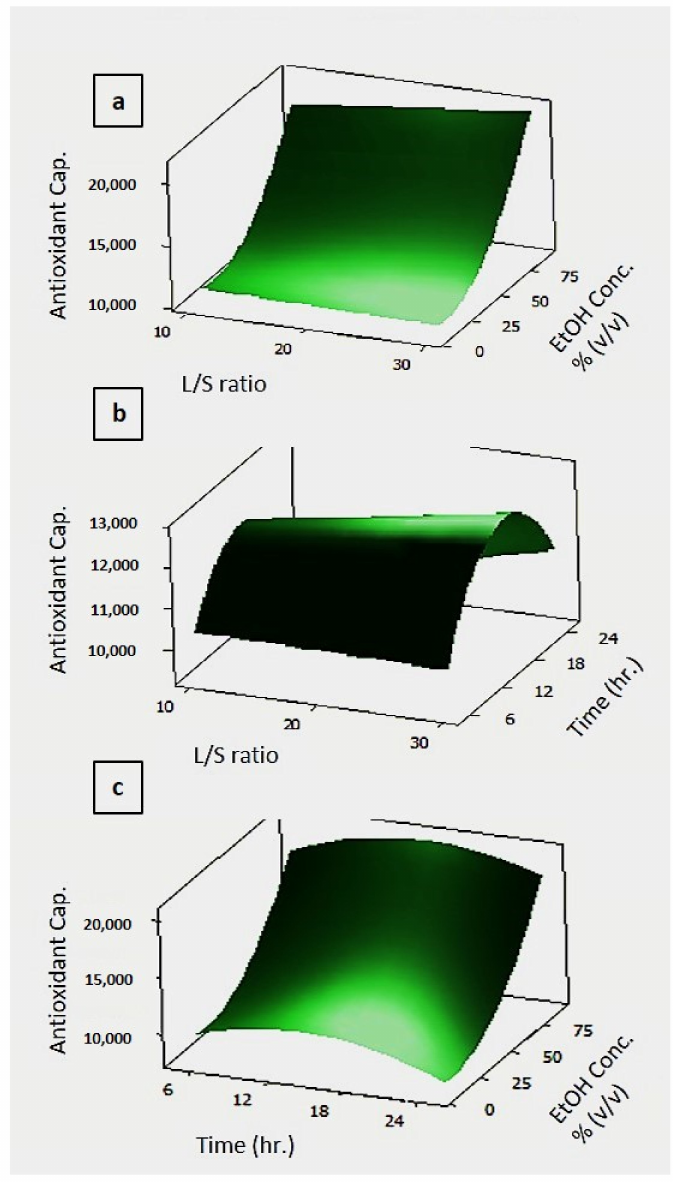
Figure 7. Effect of process parameters on the antioxidant capacity. In the figure, ( a ) antioxidant capacity vs EtOH concentration and L/S Ratio; ( b ) antioxidant capacity vs time and L/S Ratio; ( c ) antioxidant capacity vs EtOH concentration and time. The hold values are set for treatment time 15 h, ethanol concentration 50%, and L/S ratio 20. The unit for antioxidant capacity is µ M TEAC (Trolox equivalent antioxidant